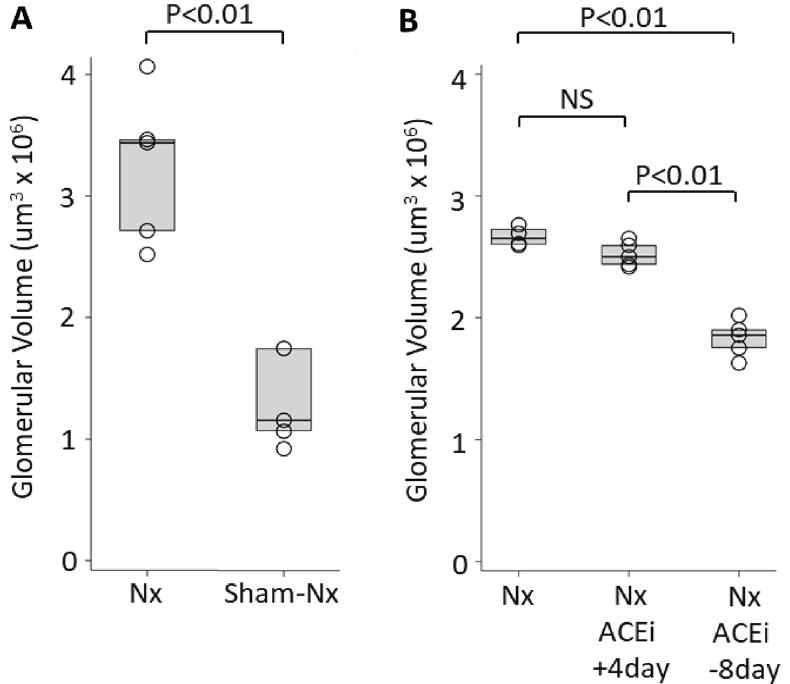
Figure 1. Panel ( A ) Glomerular volume increases by 40 weeks after uni-nephrectomy vs. Sham-nephrectomy. GV had increased 2.2-fold in nephrectomized (one kidney) versus sham-nephrectomized (two kidneys) rats. Nx n = 5, sham-Nx n = 4. Panel ( B ) The effect of ACEi treatment on GV of nephrectomized rats. ACEi treatment (enalapril 10 mg/kg/day delivered in the drinking water) starting 8 days before uni-nephrectomy resulted in a significant reduction in glomerular volume, such that GV remained comparable to that of sham- nephrectomized rats shown in Panel ( A ). In contrast, the glomerular volume of rats started on ACEi treatment 4 days after uni-nephrectomy increased to a value not significantly different from that of nephrectomized rats that did not receive ACEi. Values for glomerular volume shown are for glomerular profiles in which no glomerulosclerosis was present. Nx n = 4, ACEi + 4 days n = 5, ACEi-8 days n =